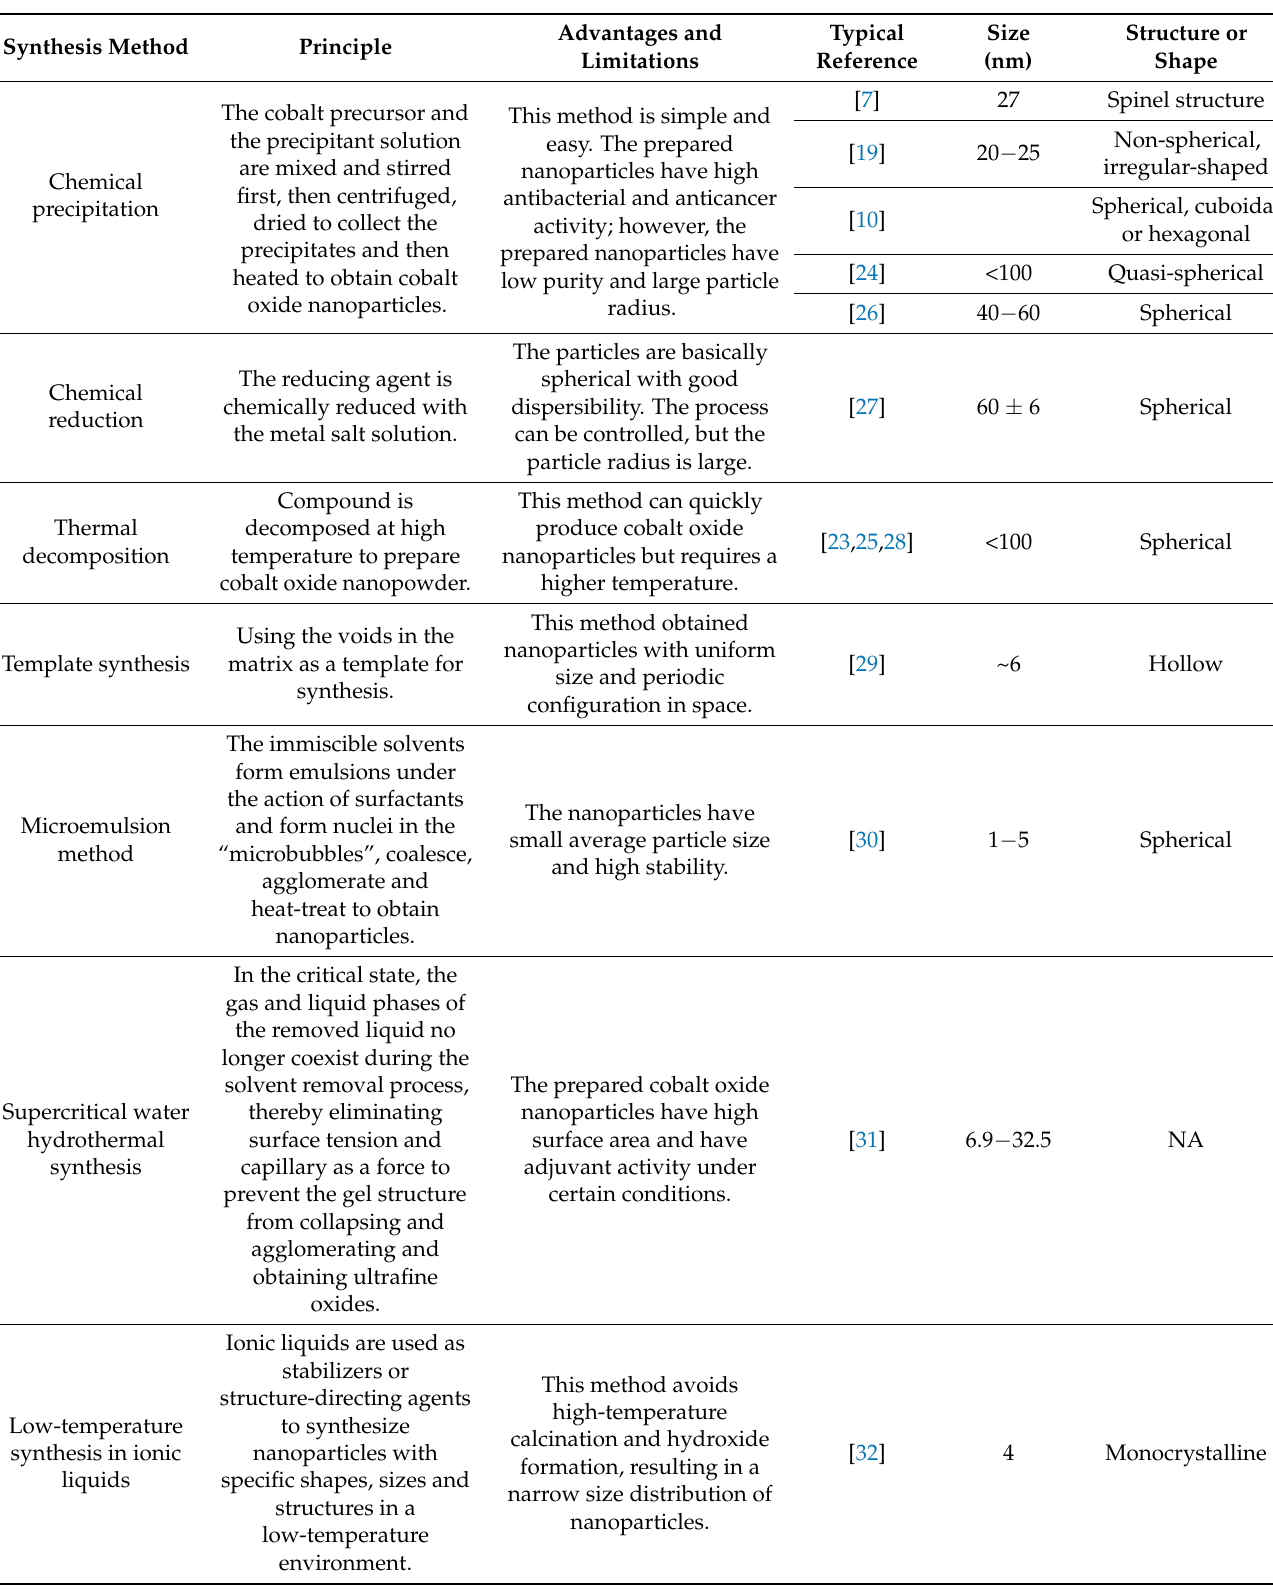
Table 1. Typical synthesis method for cobalt oxide